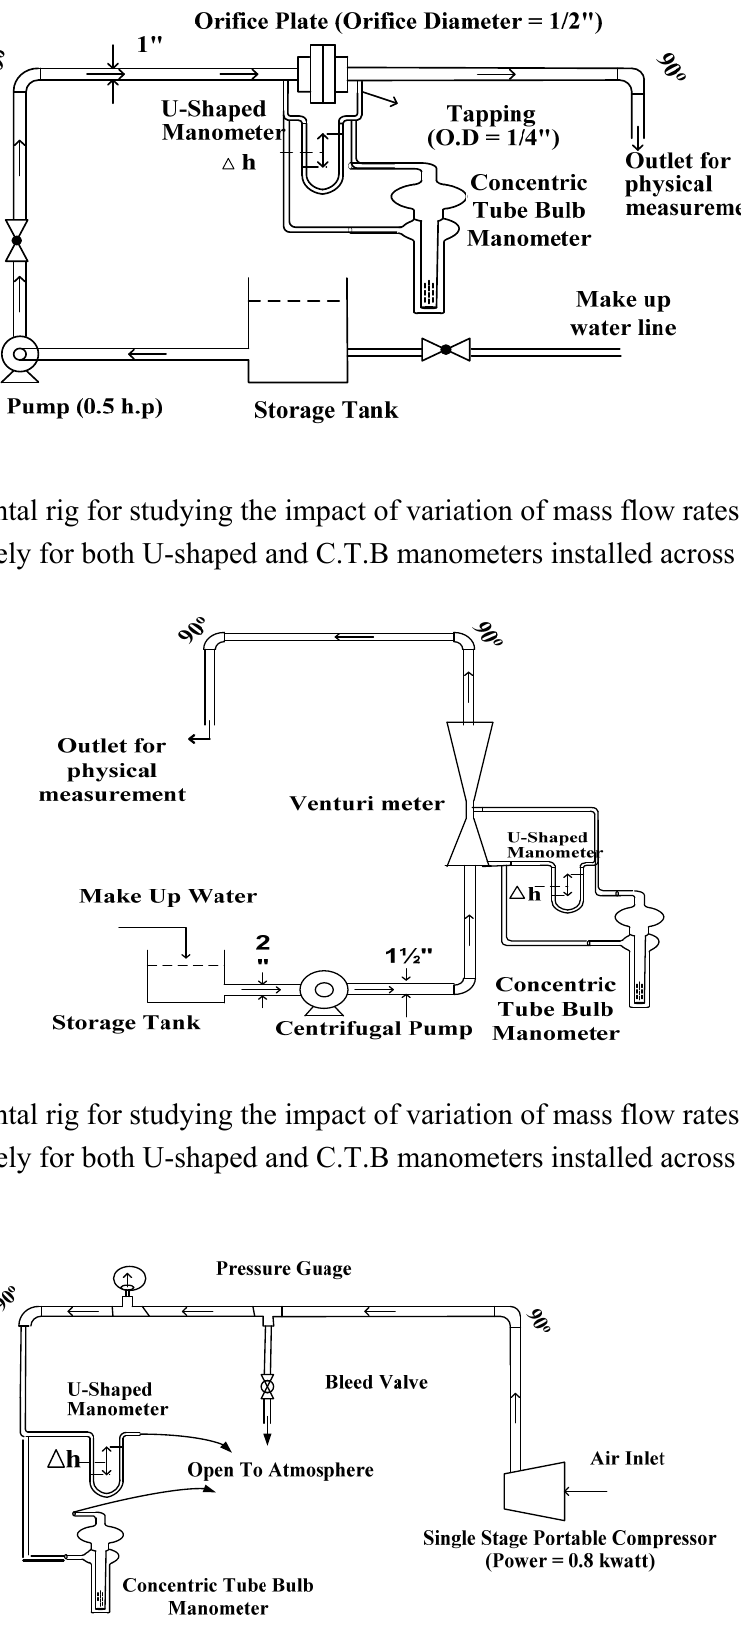
Figure 4. Setup to study the variation of gauge pressure of compressed air on the differential pressure readings using both U-shaped and C.T.B